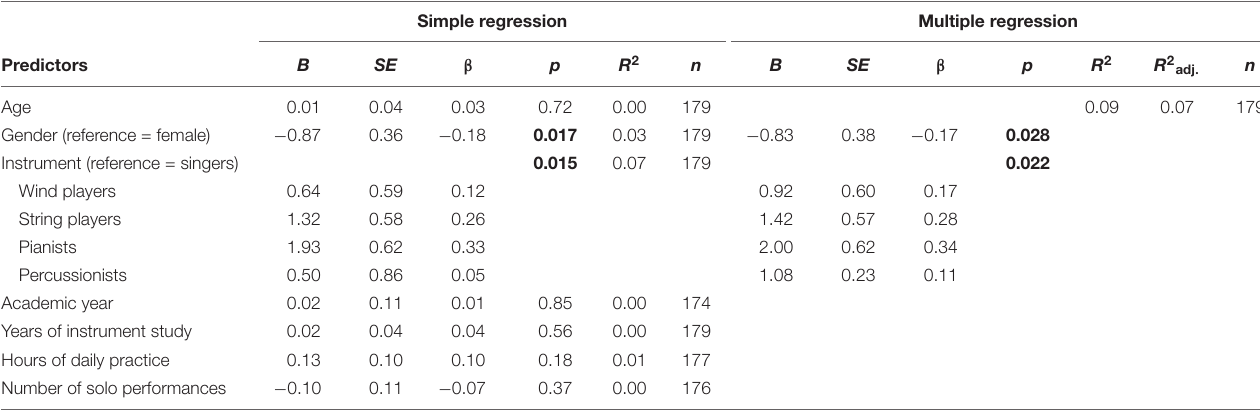
TABLE 4 | Results of the linear regression analyses for all bodily complaints. Simple regression Multiple regression